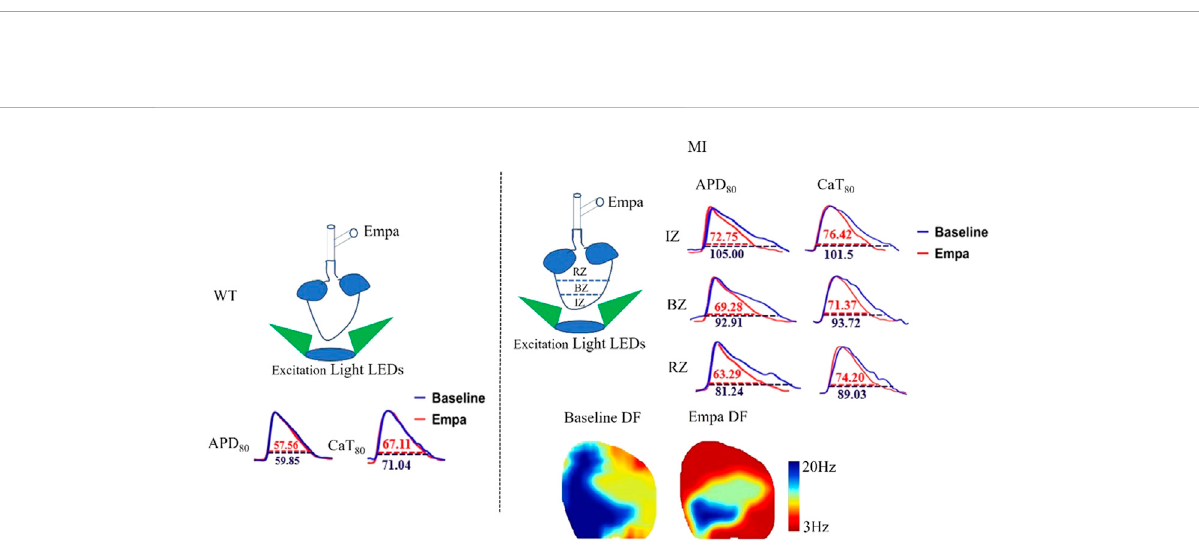
FIGURE 9 Schematic summary of the signaling pathway of EMPA and arrhythmia in